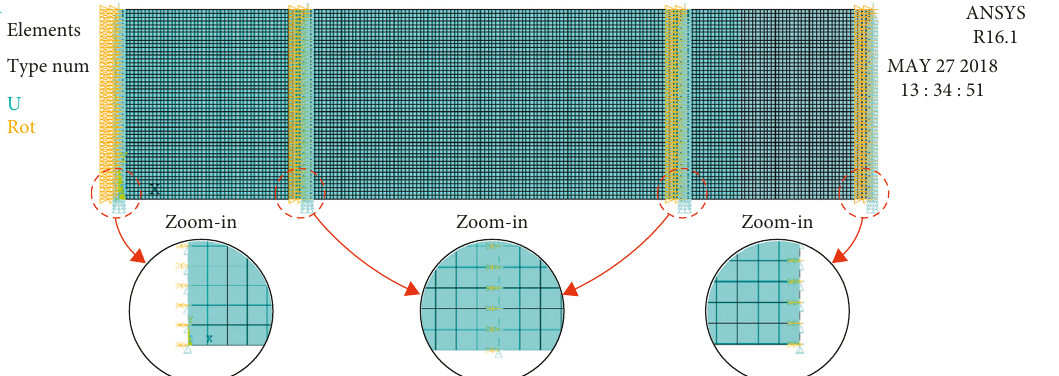
Figure 11: The finite element model created in ANSYS for evaluating natural frequencies of the three-span rectangular plate with S-S-S-S supports (Example 4).